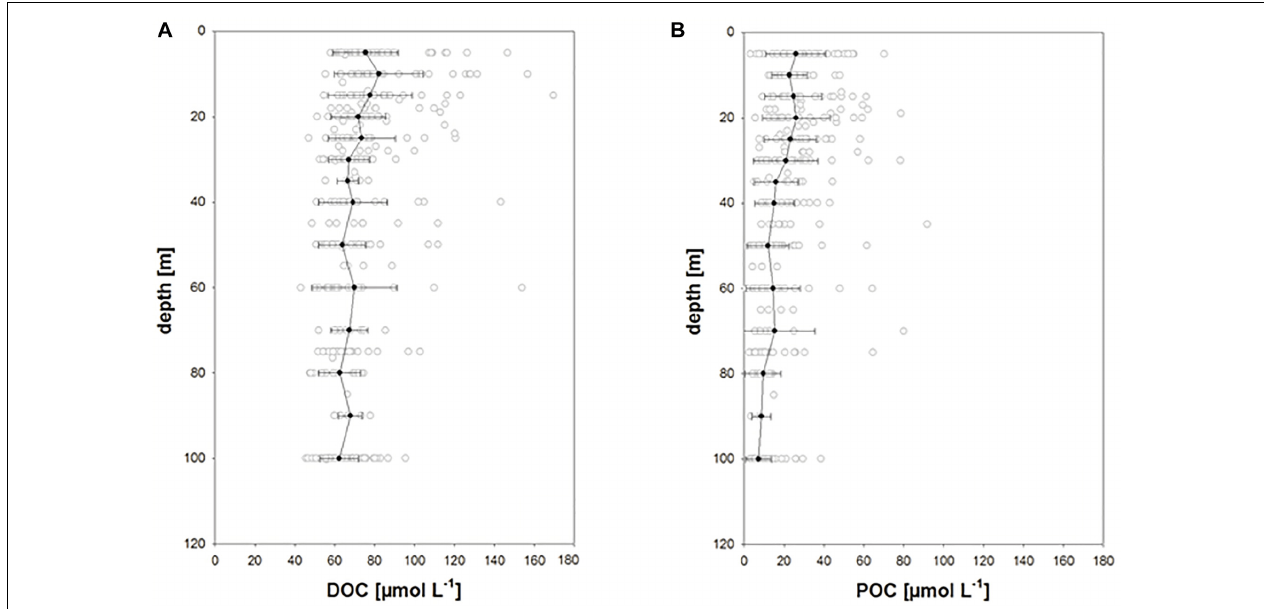
FIGURE 4 | (A,B) Depth distribution of DOC and POC concentrations in the HAUSGARTEN area including all data obtained from 2009 to 2017. Solid symbols: mean values ± 1SD calculated for rounded up depths.